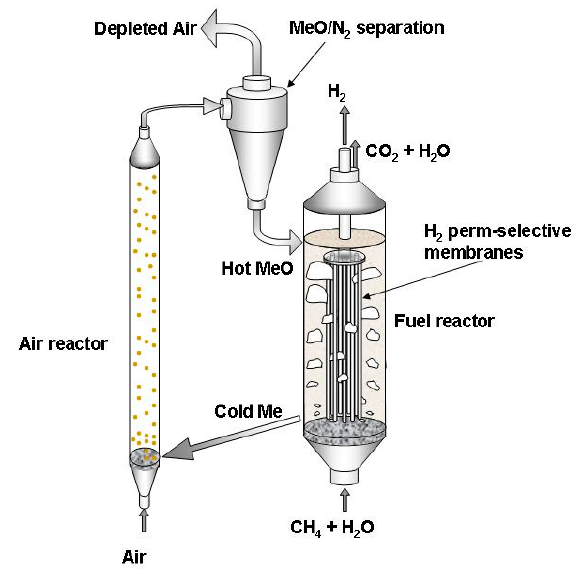
Figure 5. Schematic representation of the MA-CLR system. Reprinted from [102] with permission from Elsevier.